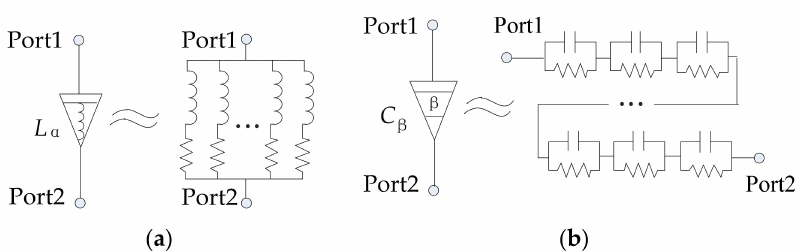
Figure 6. ( a ) The circuit with a constructed fractional-order inductor, using Oustaloup’s rational approximation method. ( b ) The circuit with a constructed fractional-order capacitor, using Oustaloup’s rational approximation method.